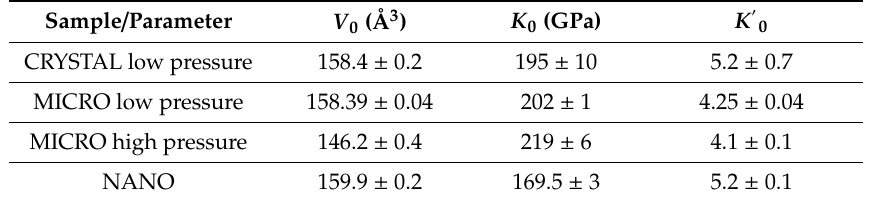
Figure 4. ( a ) Pressure dependence of the unit cell volume obtained using a LeBail refinement for the CRYSTAL and MICRO samples and using Equation (5) for the NANO sample in order to get the volume without the effect of stacking faults (see text). ( b ) Pressure dependence of the difference between the experimental data and the third-order Birch–Murnaghan equation of state. Table 1. The equation of state parameters for the CRYSTAL, MICRO and NANO samples. For the CRYSTAL sample, only the low-pressure phase parameters are presented. For the MICRO sample, the low- and high-pressure parameters are